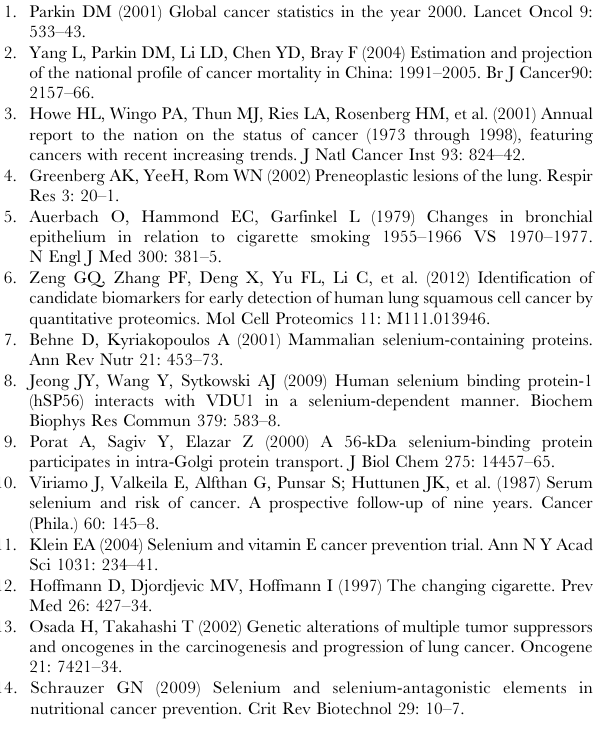
Table S1 Characteristics of formalin-fixed and paraf- fin-embedded archival tissue specimens.